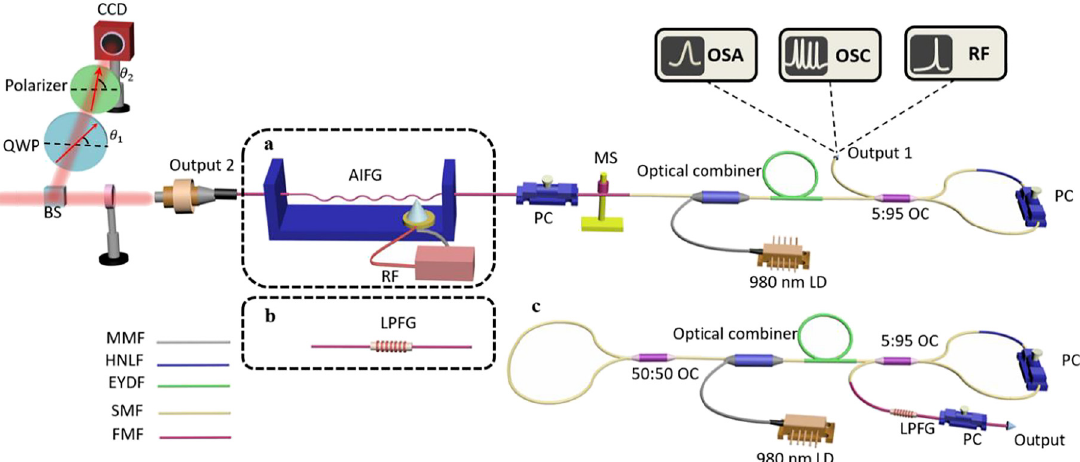
Figure 1: Experimental setup of mode-locked fiber laser used to excite intra-cavity high order mode based on (a) AIFG, (b) LPFG. (c): Experimental setup of mode-locked fiber laser used to excite extra-cavity high order mode based on LPFG. EYDF, Er: Yb Co-doped Double-clad Fiber; PC, Polarization Controller; OC, Optical Coupler; MS, mode stripper; QWP, quarter-wave plate; CCD, Charge-Coupled Device, Infrared camera.TheanglebetweenthefastaxisoftheQWPandthe x -axisis θ 1 .Theanglebetweenthetransmissionaxisofthepolarizerandthe x -axis is θ 2